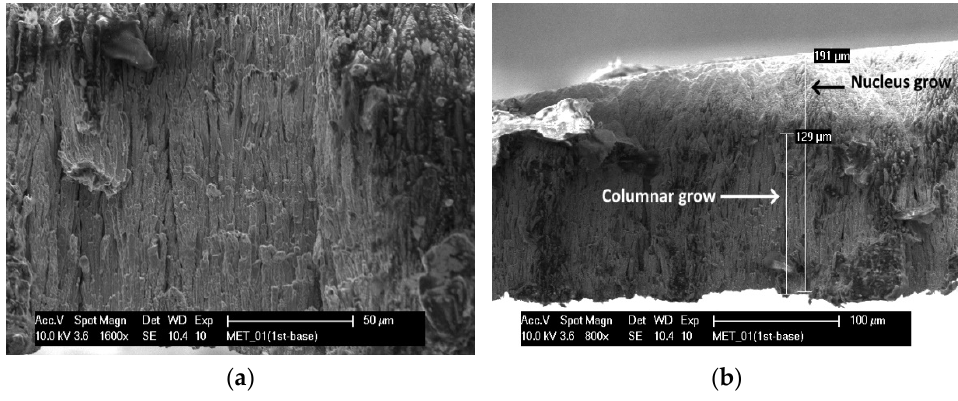
Figure 3. The cross-section SEM analysis of Cu deposit, produced with MS technique: columnar growth at the beginning of the layer ( a ) and changing from columnar to nucleus growth after the 100 µm ( b ).